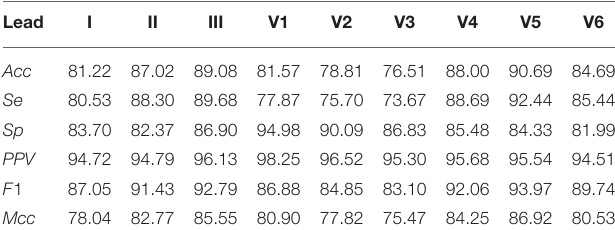
TABLE 6 | Majority of voting ECM-image classification performance on Monzino-AF DB.